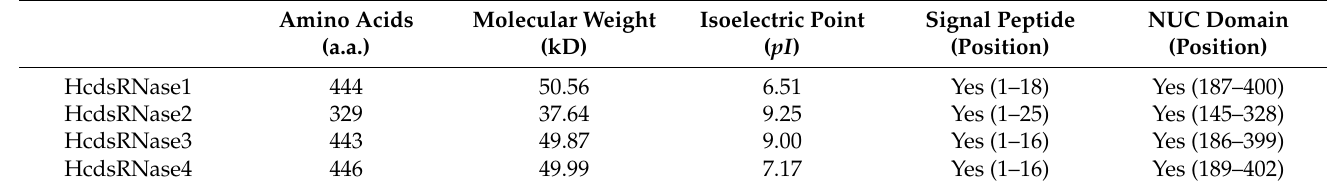
Table 1. Properties of NUC proteins from H. cunea .